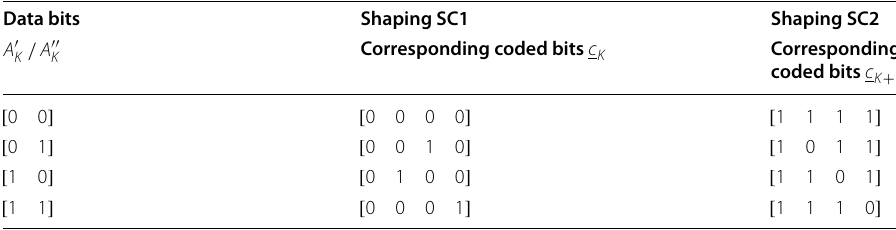
3 in the case of 16-QAM modulation = 2, n s 4 ) = =